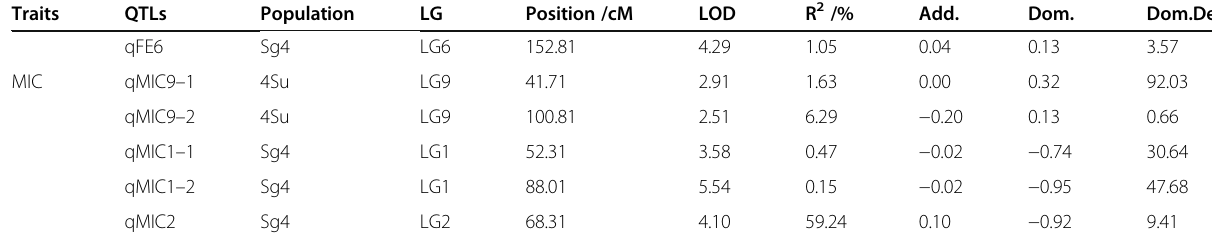
Table 3 Summary of QTLs identified in four populations for 8 traits (Continued)